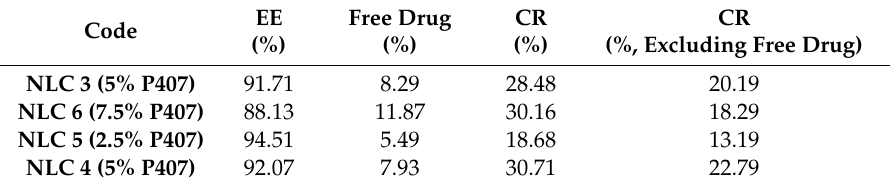
Table 3. In vitro raloxifene hydrochloride (RLX) release and EE (%) of the selected NLC formulations. NLC 3, 5 and 6 are with varied surfactant concentrations while NLC 4 is with varied sonication time.